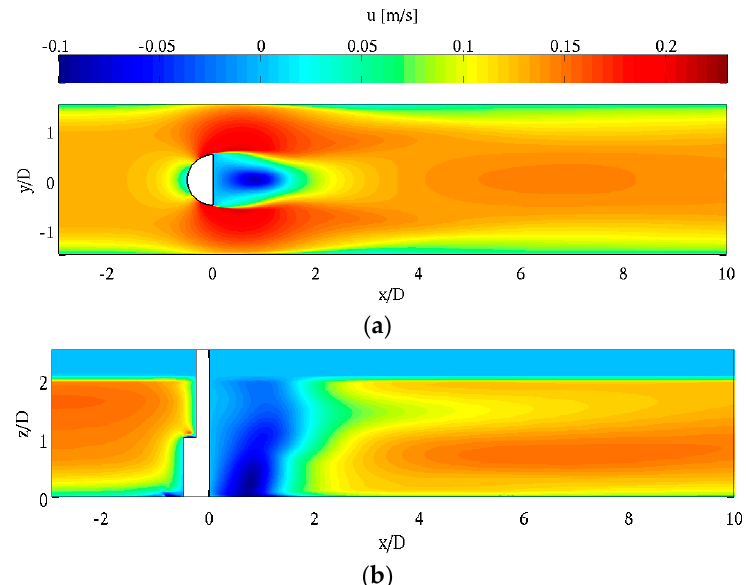
Figure 4. Averaged streamwise velocity at ( a ) z / D = − 0.5; and ( b ) y / D = 0.0.